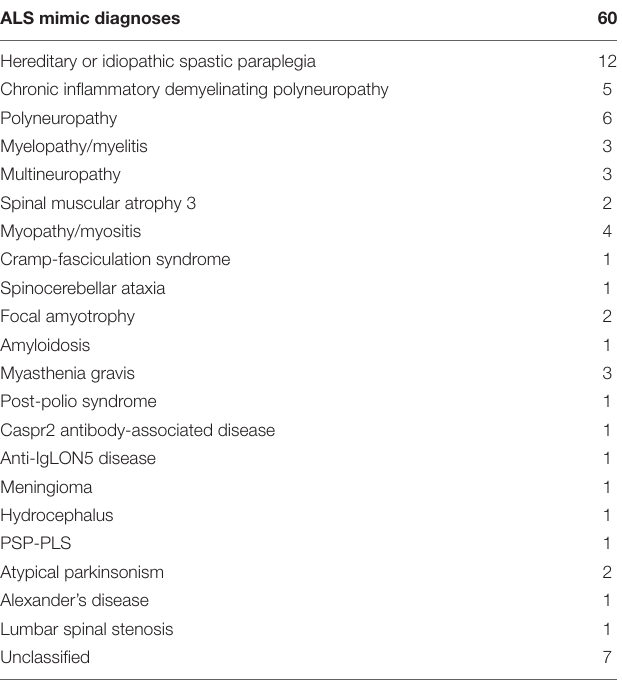
TABLE 2 | Diagnostic categories in the ALS mimics group.